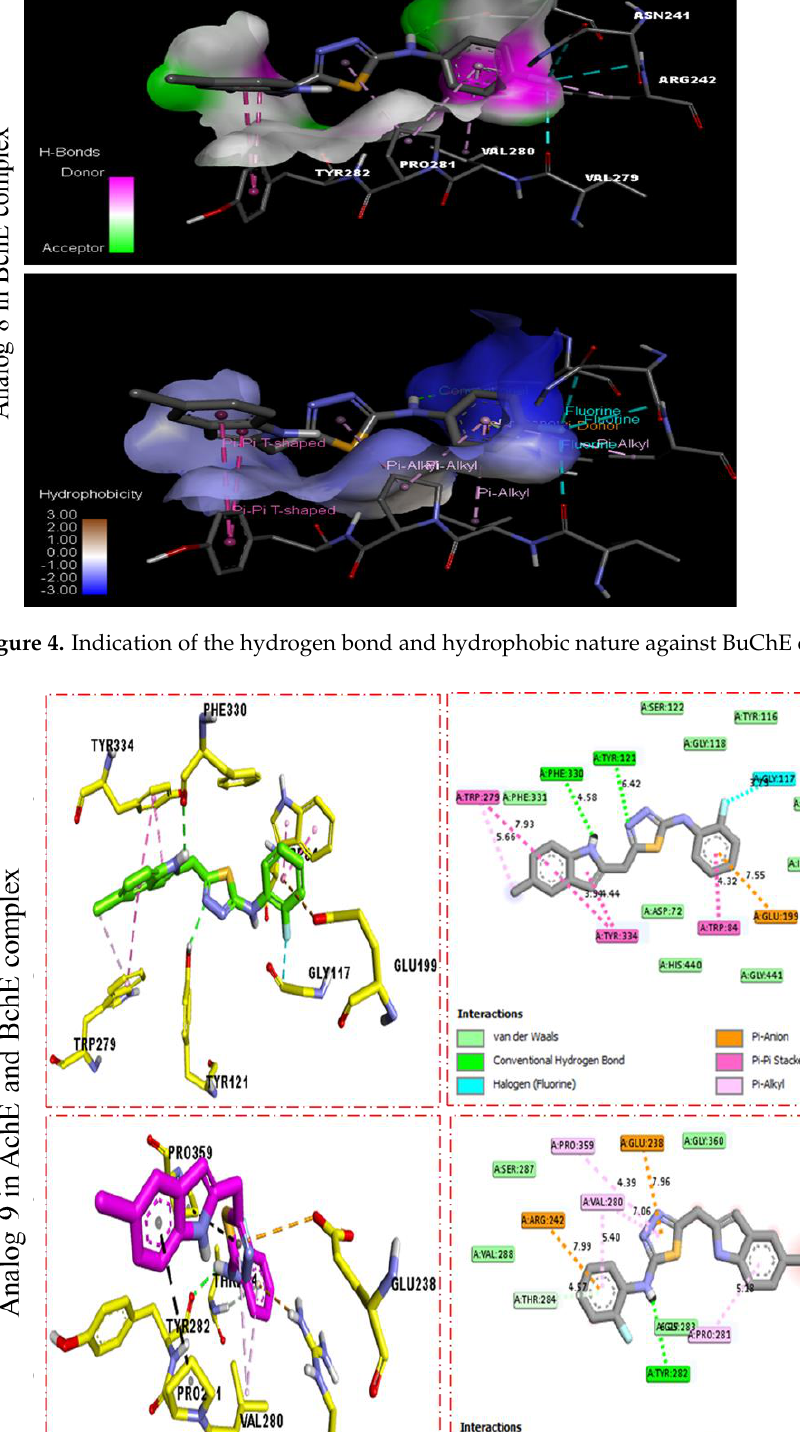
Figure 3. Indication of the hydrogen bond and hydrophobic nature against AChE of compound 8 .